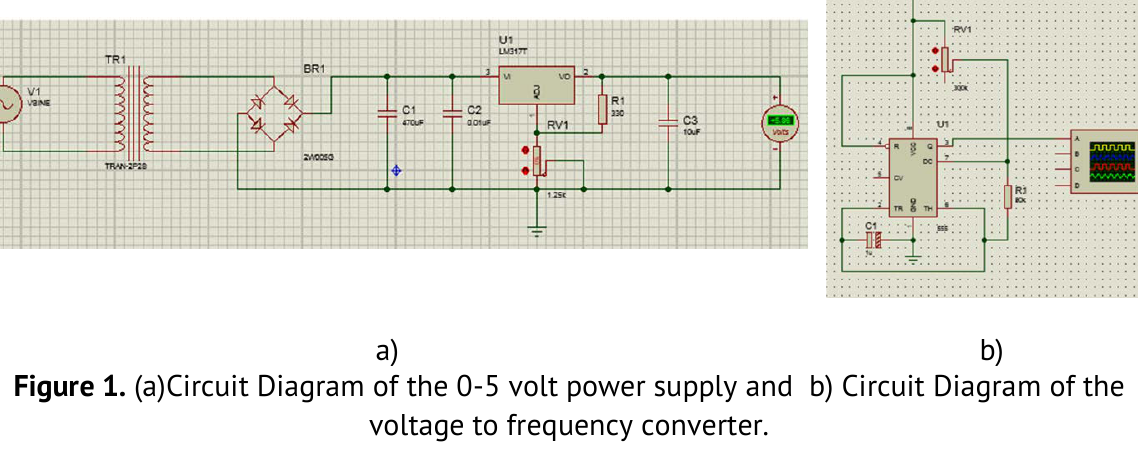
Figure 1. (a)Circuit Diagram of the 0-5 volt power supply and b) Circuit Diagram of the voltage to frequency converter.